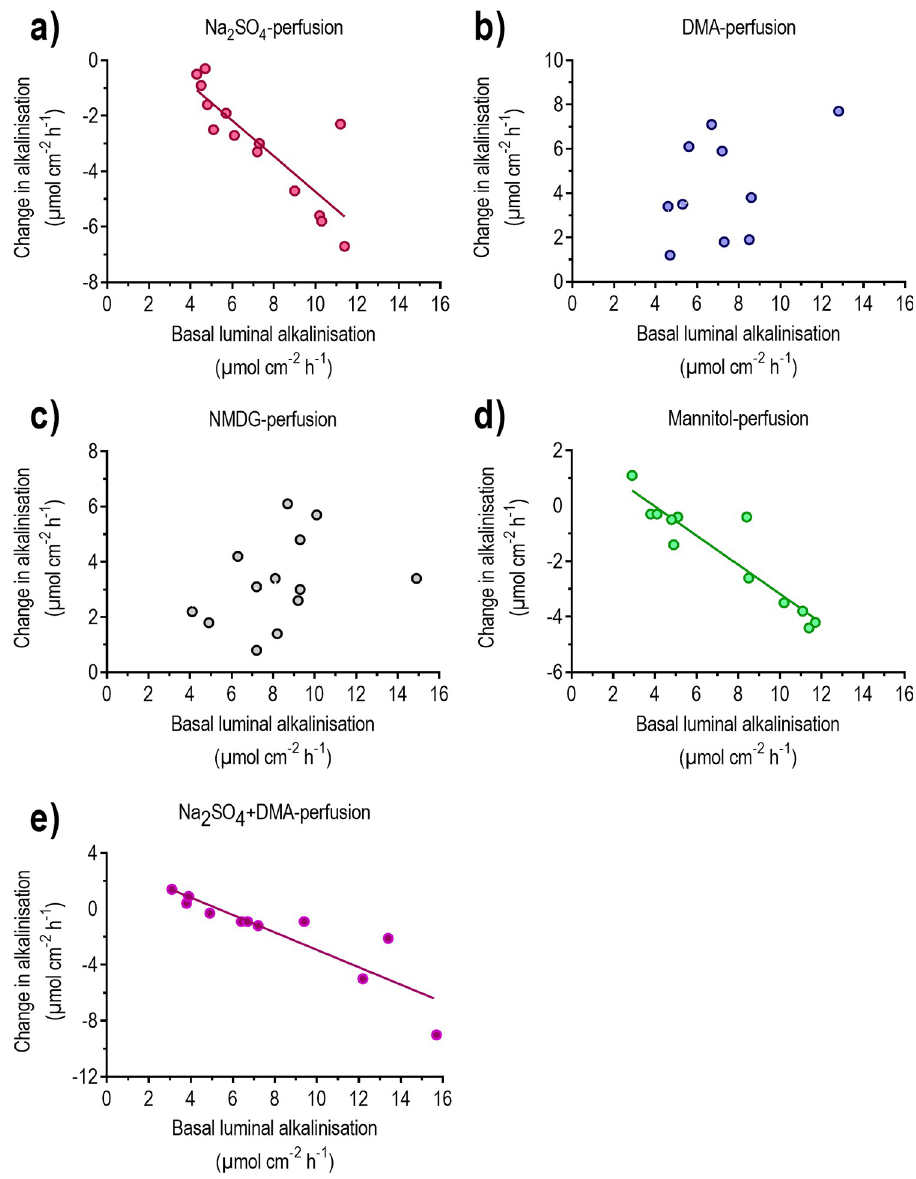
Fig 4. The relationship between the changes in luminal alkalinisation in response to different luminal solutions and basal luminal alkalinisation. The duodenum was perfused for 40 min with (a) Cl - -free Na 2 SO 4 , (b) Na + -free NMDG, (c) dimethylamiloride (DMA), (d) NaCl-free D-mannitol, or (e) Cl - -free Na 2 SO 4 plus DMA. Each x-y value is the mean of three basal values before treatment and the mean of the two last values in response to treatment. Regression analysis: (a). y = -0.64x + 1.68, r 2 = 0.70, P < 0.001, n = 14. (b) y = 0.21x + 1.55, r 2 = 0.12, P = 0.25, n = 13. (c). y = 0.40x + 1.32, r 2 = 0.19, P = 0.21, n = 10. (d). y = -0.52x + 2.08, r 2 = 0.86, P < 0.001, n = 12. (e). y = -0.62x + 3.31, r 2 = 0.79, P = 0.001, n =